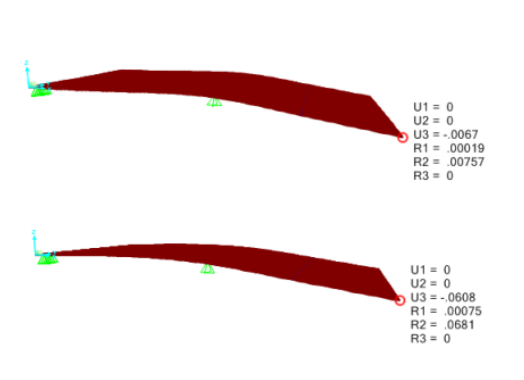
Figure 9. Numerical model in SAP2000 for Fpok = 1.00 kN (up) and Fpok = 6.55 kN (down). (U-displacement, R-rotation, 1-x axis, 2-y axis, 3-z